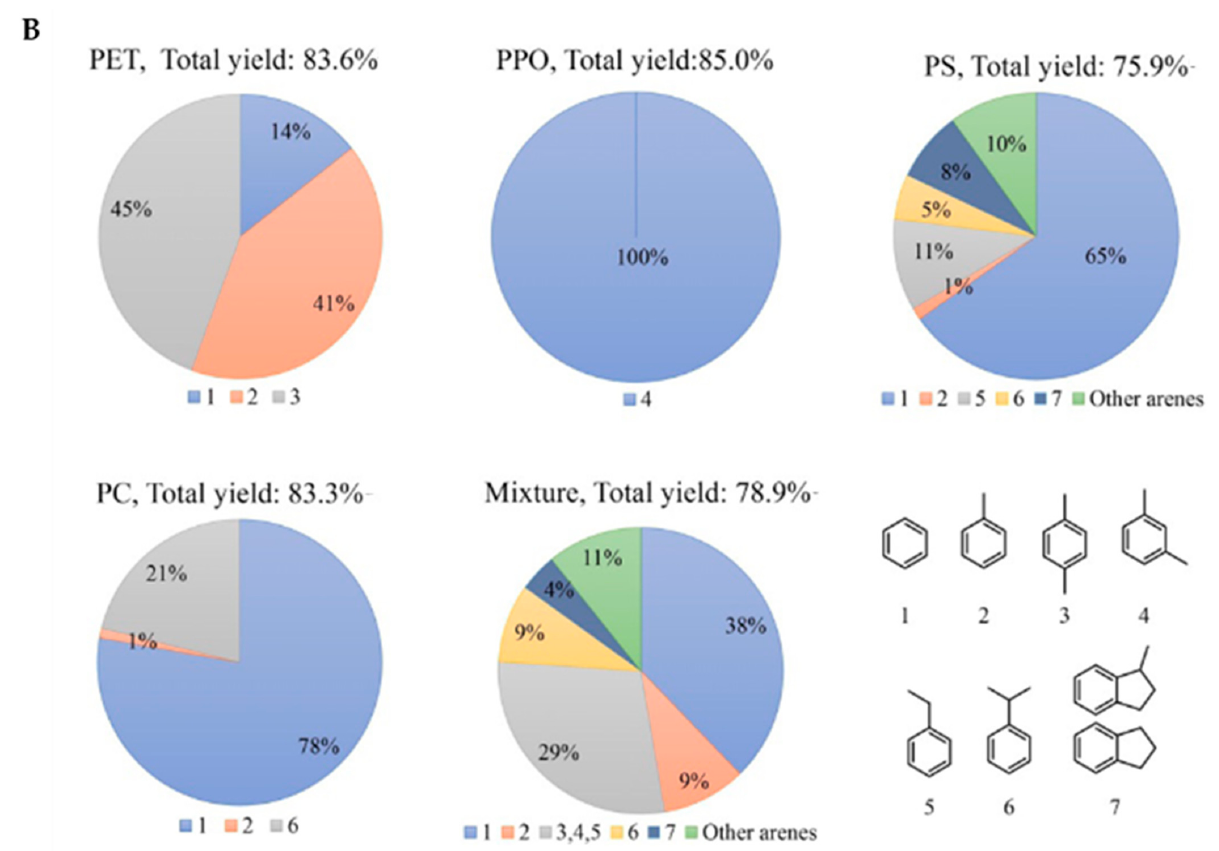
Figure 6. ( A ) Data characterizing the performances of various catalysts in the conversion of PET. Reaction conditions: 0.1 g PET, 0.1 g catalyst, 10 g H 2 O, 200 ◦ C, 12 h, and 0.3 MPa H 2 [116]. ( B ) Results of the conversion of various aromatic plastics over Ru–Nb 2 O 5 catalyst [116]. ( C ) Scheme showing the processes of polylactic acid natural degradation and catalytic conversion